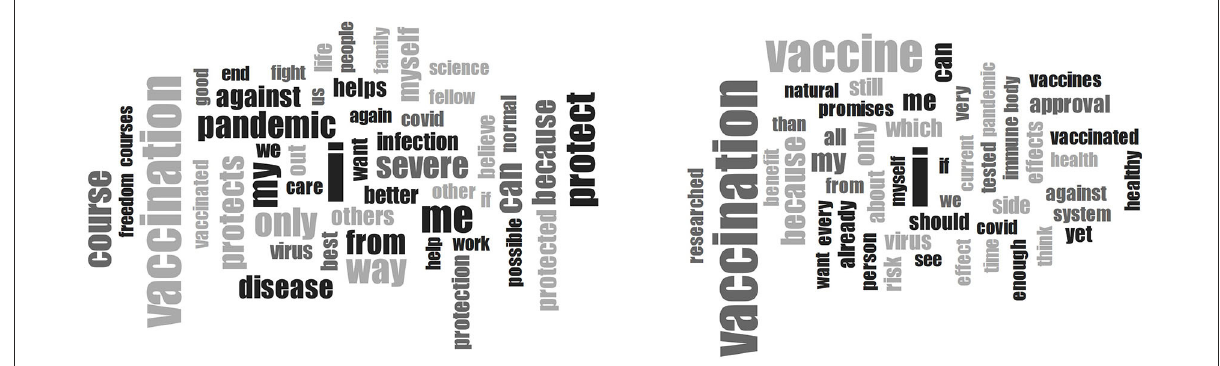
FIGURE2 Word clouds of item 2 (“When I think about the COVID-19 vaccination, I believe”) of vaccinated vs. unvaccinated workers in the healthcare sector.